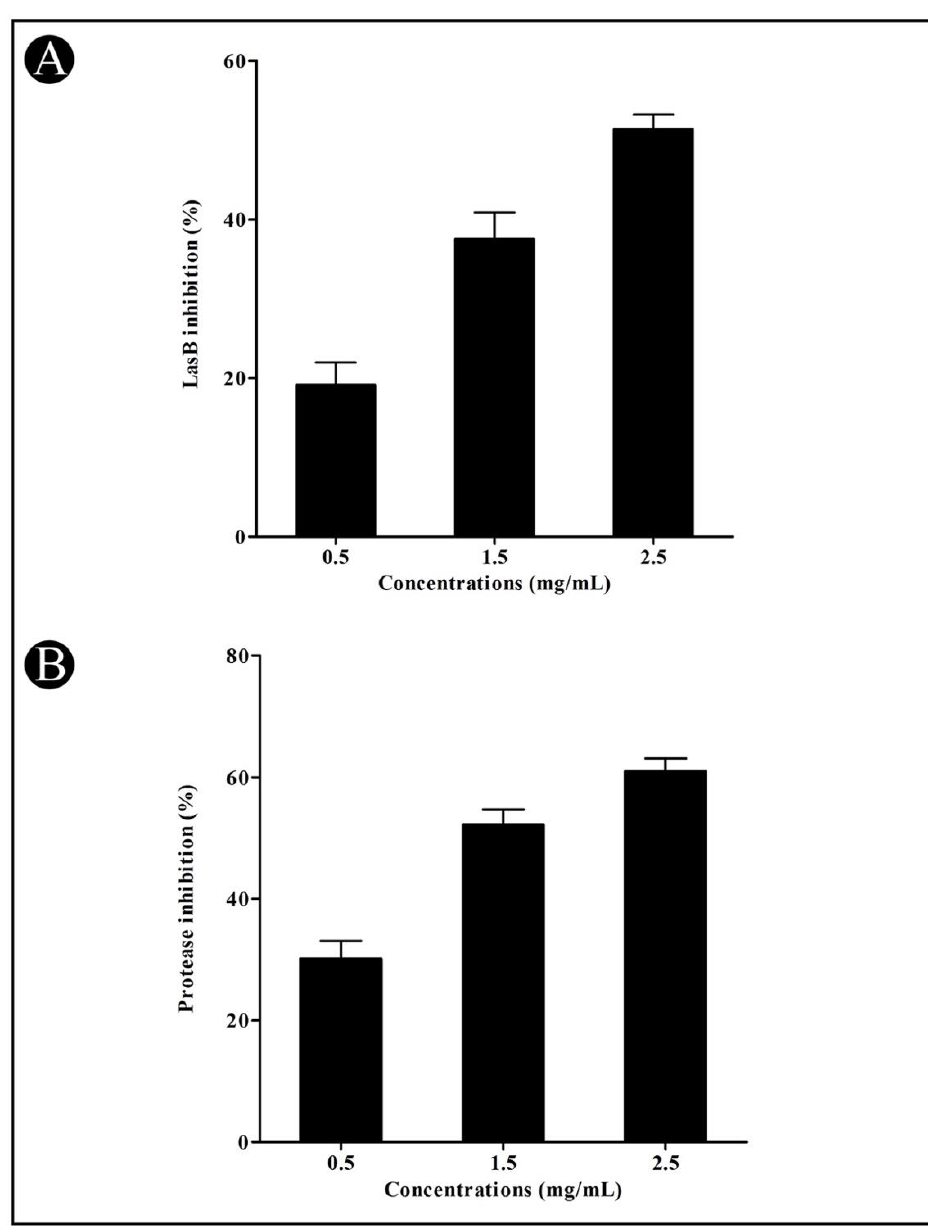
Figure 3. Inhibition of LasB and protease by the crude L. plantarum biosurfactant in P. aeruginosa at sub-MIC concentrations (0.5, 1.5, and 2.5 mg/mL). LasB ( A ) and activity of protease ( B ) were detected by a UV–VIS spectrophotometer and presented as percentage inhibition (with respect to untreated control). Values are represented as mean ± SD of three independent experiments.